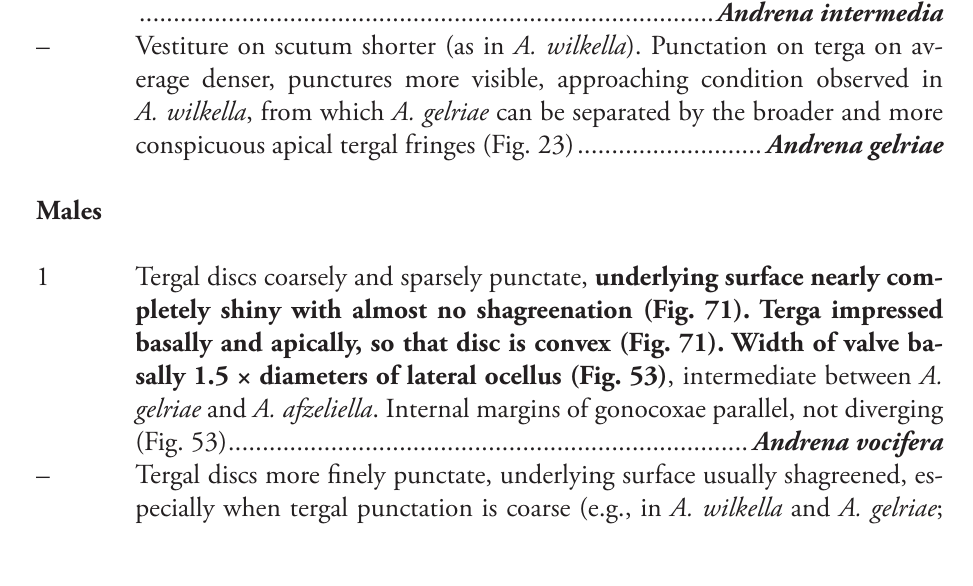
usually darker in fresh specimens. Colour of terminal fringe variable. Body length variable ............................................................................................ 6 6 Apical hairbands of T3 not interrupted medially in fresh specimens (Figs 19, 20). Terminal fringe dark brown, grey-white to yellowish white, generally not uniformly orange (Figs 9, 10). Slightly smaller, on average 8–10 mm ......... 7 – Apical hairbands of T3 interrupted medially even in fresh specimens (Figs 13, 14, 23, 24). Terminal fringe mostly uniformly orange (Figs 13, 14). Slightly larger, 9–12 mm ......................................................................................... 8 7 Terminal fringe dark brown (Fig. 10). Hairs flanking basitibial plate of hind tibia dark brown (Fig. 30); dorsal part of tibial scopa usually with a few dark hairs (Fig. 30). Vestiture on vertex, scutum and scutellum grey-brown, scu- tum mostly with minute, dark hairs beneath longer vestiture. Apical tergal hairbands often yellowish. In direct comparison, clypeal punctation on aver- age coarser, underlying sculpture shiny (Fig. 32). Slightly larger, body length 9–10 mm ........................................................................... Andrena ovatula – Colour of terminal fringe variable (Figs 4, 9), but always lighter, from light grey-white to yellowish white or yellowish orange, rarely brown (Fig. 9), then always with orange hue. Hairs flanking basitibial plate of hind tibia golden or brown, then with orange hue (Fig. 29); tibial scopa without dark hairs dorsally. Vertex and scutal vestiture yellow-brown, apical tergal hairbands often white. Clypeal punctation on average shallower and sparser, underlying sculpture matt (Fig. 31). Slightly smaller, body length 8–10 mm ..... Andrena afzeliella The following two species are particularly difficult to separate in the female sex. 8 Vestiture on scutum slightly longer, nearly twice as long as width of antennae; punctation on terga on average less dense and less visible (Fig. 24) ............... .................................................................................... Andrena intermedia – Vestiture on scutum shorter (as in A. wilkella ). Punctation on terga on av- erage denser, punctures more visible, approaching condition observed in A. wilkella , from which A. gelriae can be separated by the broader and more conspicuous apical tergal fringes (Fig. 23) ........................... Andrena gelriae Males 1 Tergal discs coarsely and sparsely punctate, underlying surface nearly com- pletely shiny with almost no shagreenation (Fig. 71). Terga impressed basally and apically, so that disc is convex (Fig. 71). Width of valve ba- sally 1.5 × diameters of lateral ocellus (Fig. 53) , intermediate between A. gelriae and A. afzeliella . Internal margins of gonocoxae parallel, not diverging (Fig. 53) ............................................................................ Andrena vocifera – Tergal discs more finely punctate, underlying surface usually shagreened, es- pecially when tergal punctation is coarse (e.g., in A. wilkella and A. gelriae